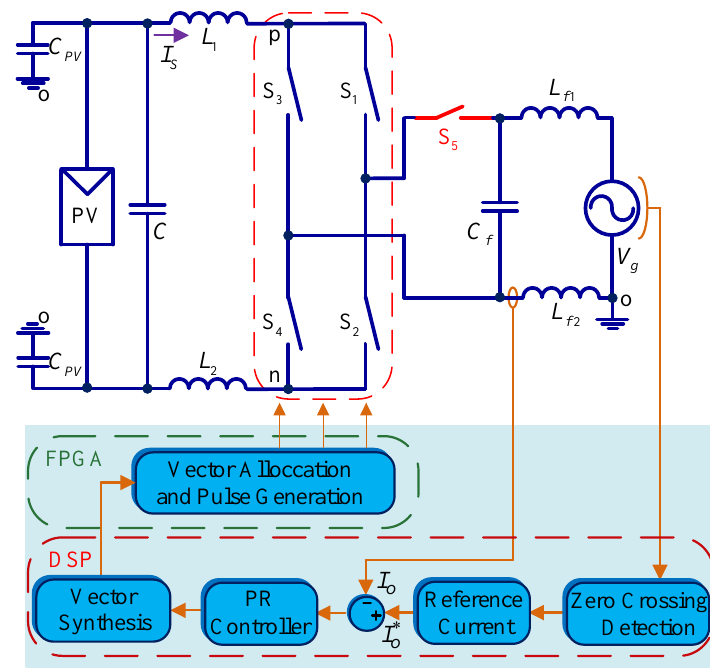
Figure 7. Control structure of the proposed inverter.